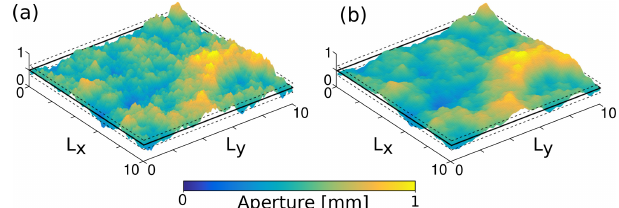
Figure 2. Two aperture fields constructed from synthetic fractures. Both aperture fields are based on the same sets of random num- bers with varying Hurst exponents H , which are (a) 0 . 4 and (b) 0 . 8. The two statistical parameters ( a and σ a ) are indicated by solid and dashed black lines, respectively. Axis units are in millimeters, while the vertical axis (indicating aperture) is exaggerated by a factor of 2 for clarity. Note that a and σ a are identical for panels (a) and (b) . Increasing height fluctuations at smaller scales, caused by a lower Hurst exponent, results in a larger effective surface area S for frac- ture (a) compared to panel (b)